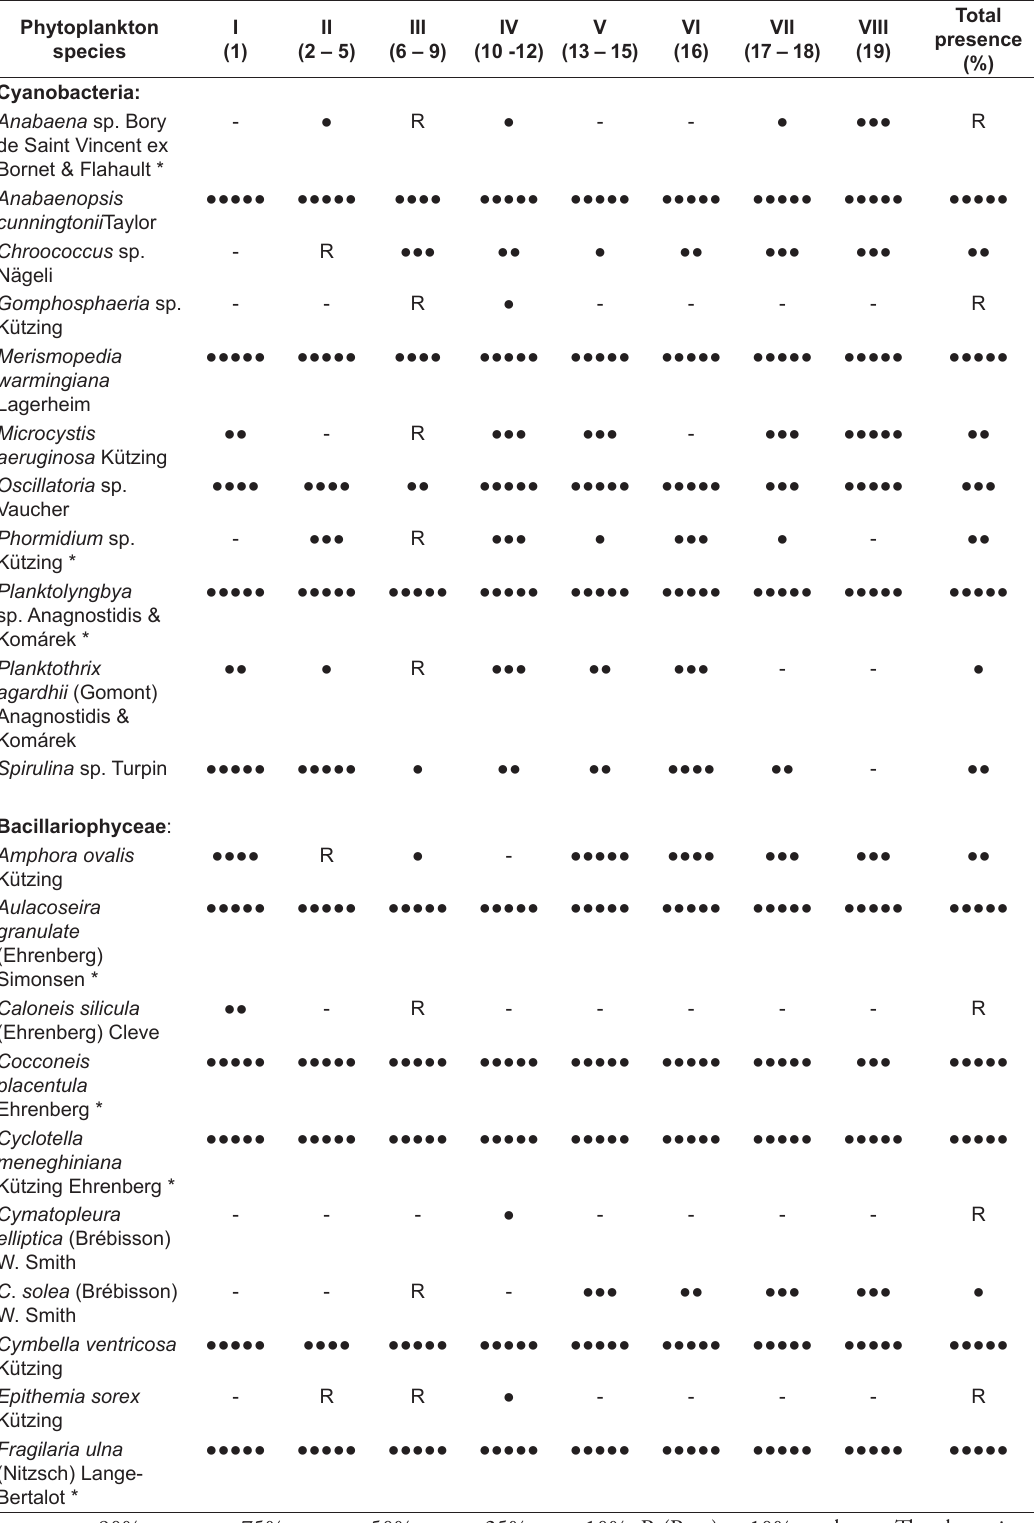
Table 2. Phytoplankton species recorded along the main stream of the Nile in Upper Egypt and their presence contributions (%) of the eight phytoplankton clusters distinguished after the application of Twinspan classification. Phytoplankton